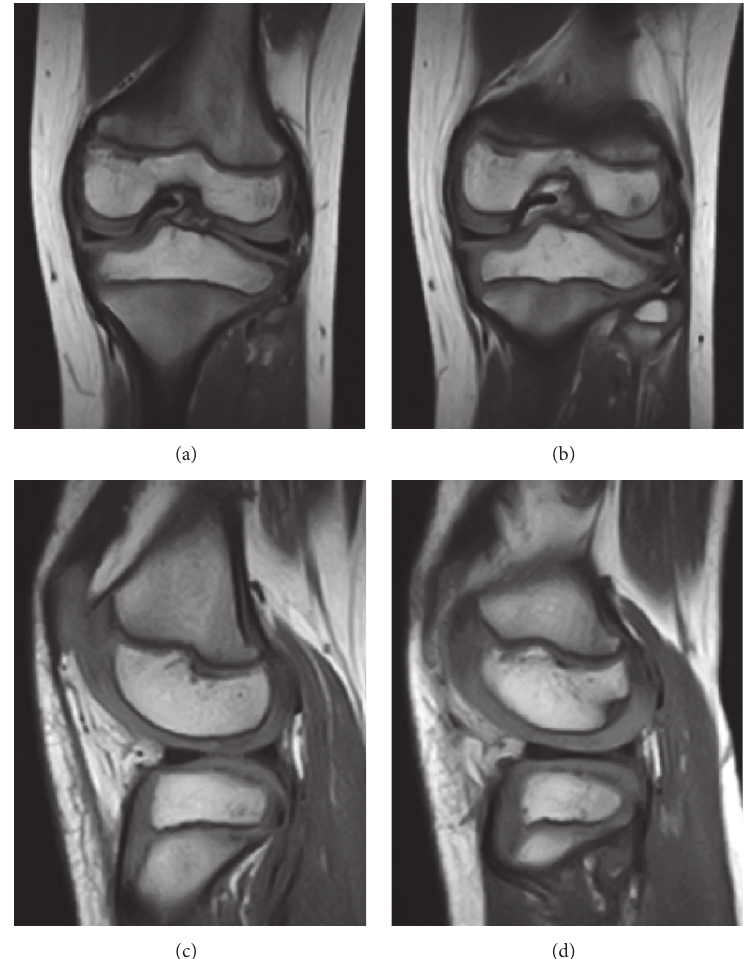
Figure 1: T1-weighted magnetic resonance images. Coronal (a, b) and sagittal (c, d) sections showing normal findings of the lateral